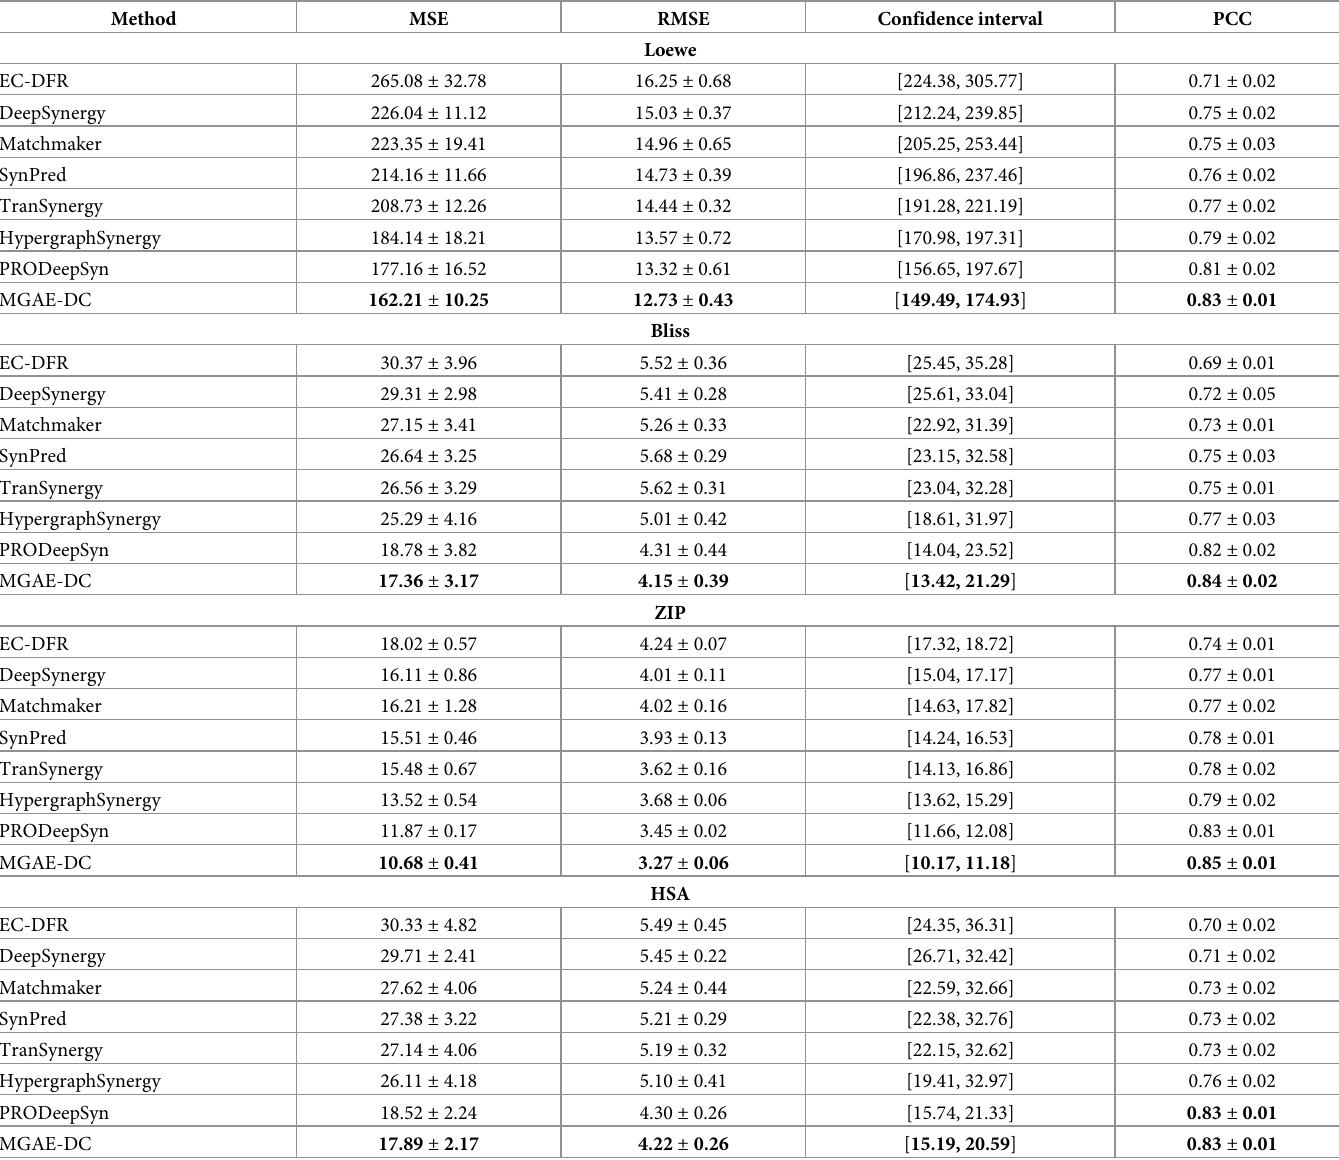
Table 1. The synergy score regression performances on the O’Neil dataset, in terms of mean and standard